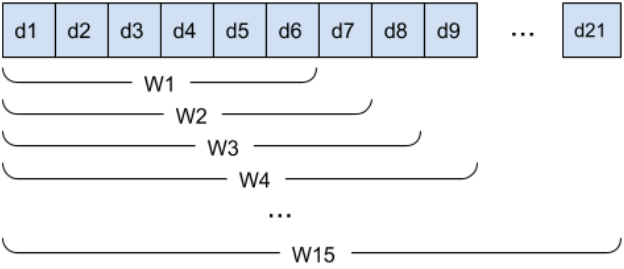
Figure 4. Time windows W1, W2, …, W15 are defined incrementally starting from a period of 6 consecutive days, which has been considered the minimum number of data points to calculate the fitting function.